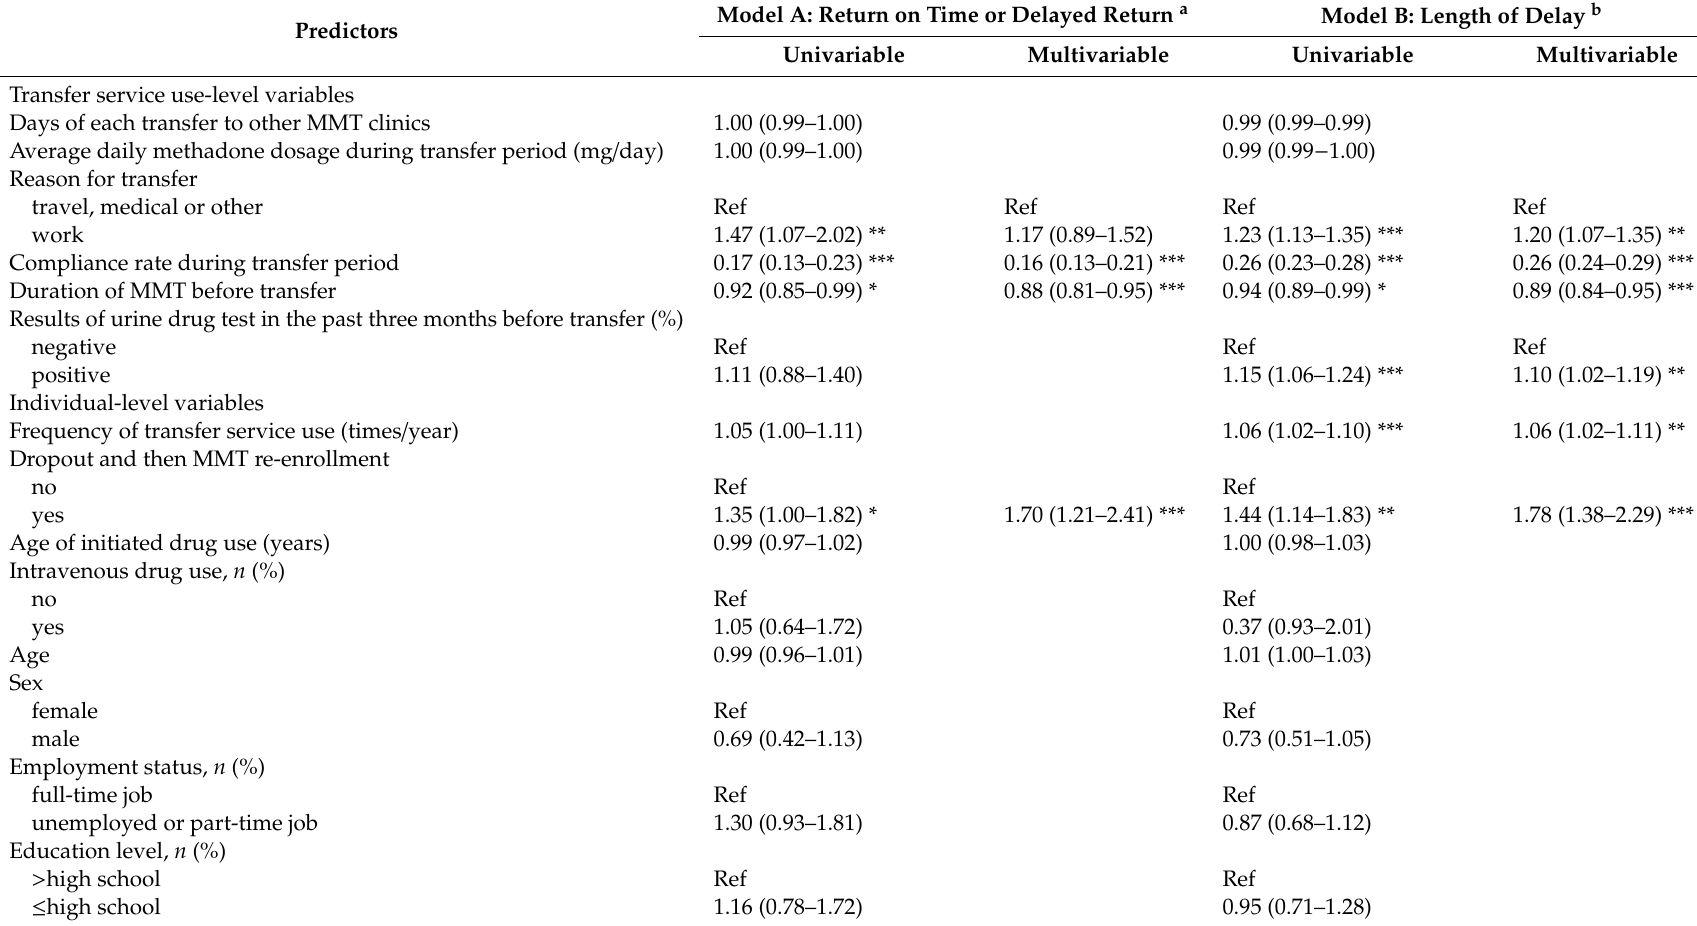
Table 3. The association between transfer service use and delayed return of transferred patients, obtained from the multilevel regression